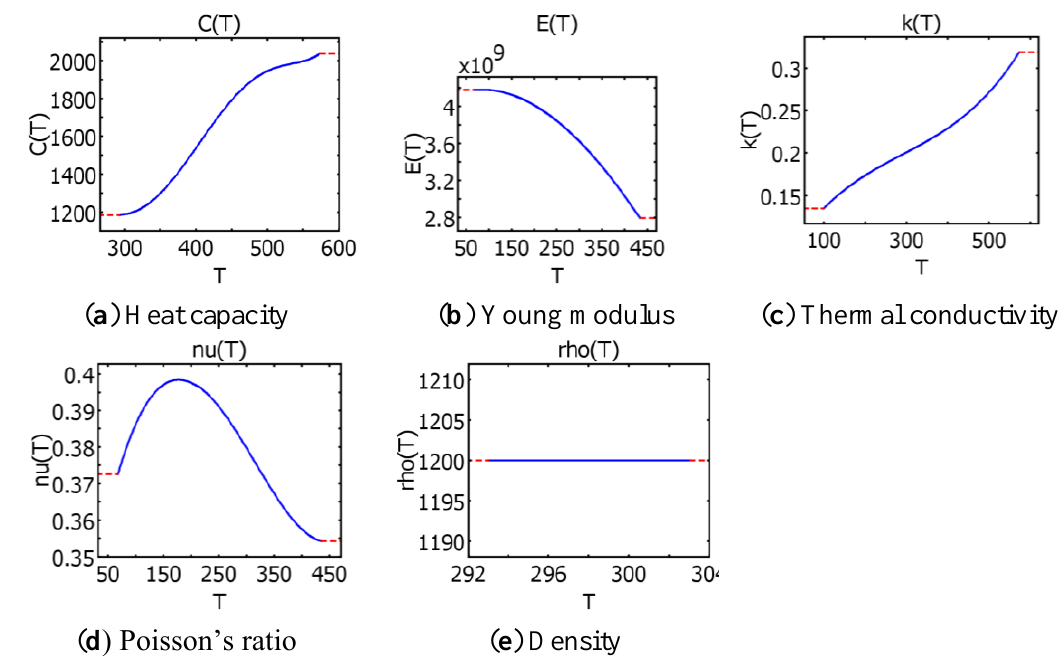
Figure 6. Thermal dependencies of polycarbonate material properties (COMSOL Multiphysics 3.5a material